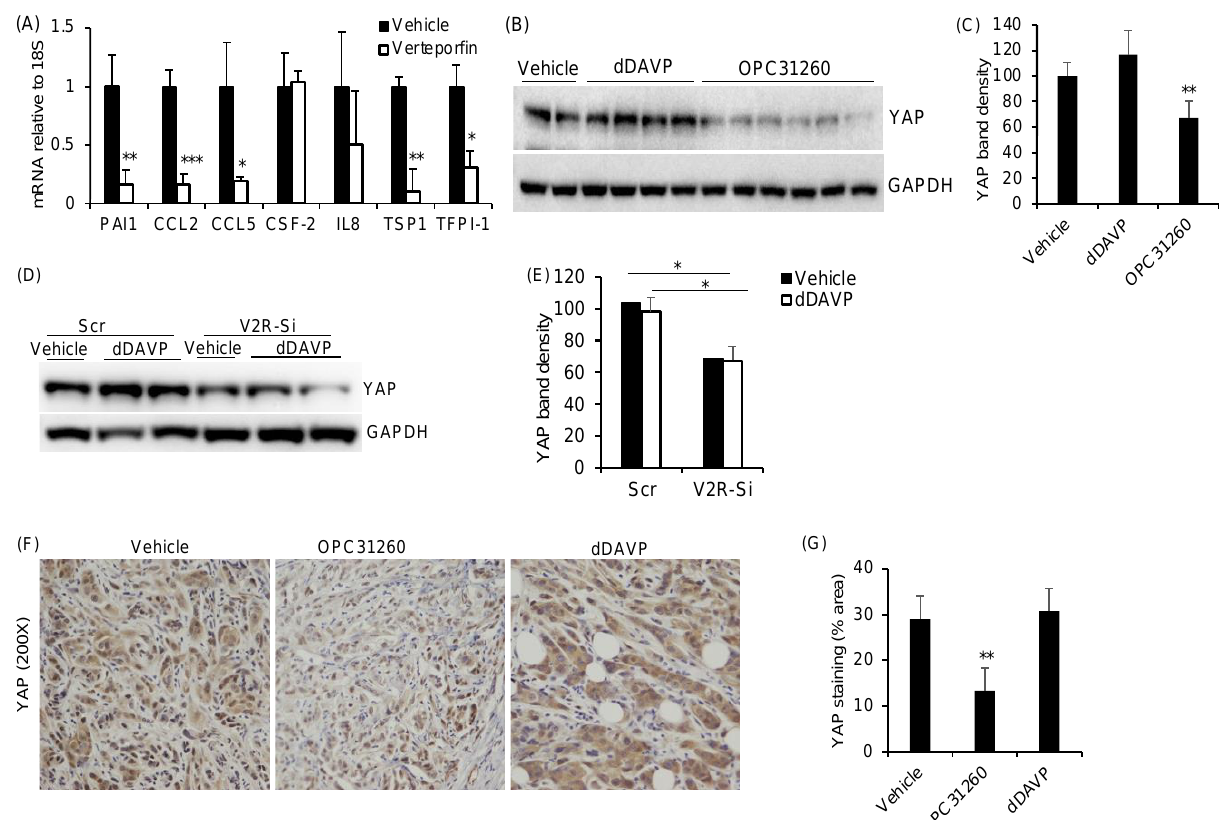
Figure 4. V2R regulates YAP in ccRCC tumor cells: ( A ) mRNA levels of secreted proteins relative to 18 S mRNA in Caki1 cells treated with YAP inhibitor, verteporfin (2.5 µM for 16 h) ( n = 4). ( B ) Immunoblot for Caki1 cells treated with vehicle, dDAVP (1nM) or OPC31260 (25 µ M) for 24 h, and ( C ) Quantitation of band density. ( D ) Immunoblot for YAP in Caki1 cells transfected with Scr or V2R-SiRNA for 48 h and treated with vehicle or dDAVP (1 nM, 30 min), and ( E ) Quantitation of band density. ( F ) Immunostaining of mouse xenograft tumor tissue sections for YAP (brown) from study shown in Figure 1A. ( G ) Quantitation of staining intensity for YAP in mouse tumor. ( n = 4 tumors per group). * p < 0.05, ** p < 0.01, *** p < 0.001 vs. vehicle by t -test.